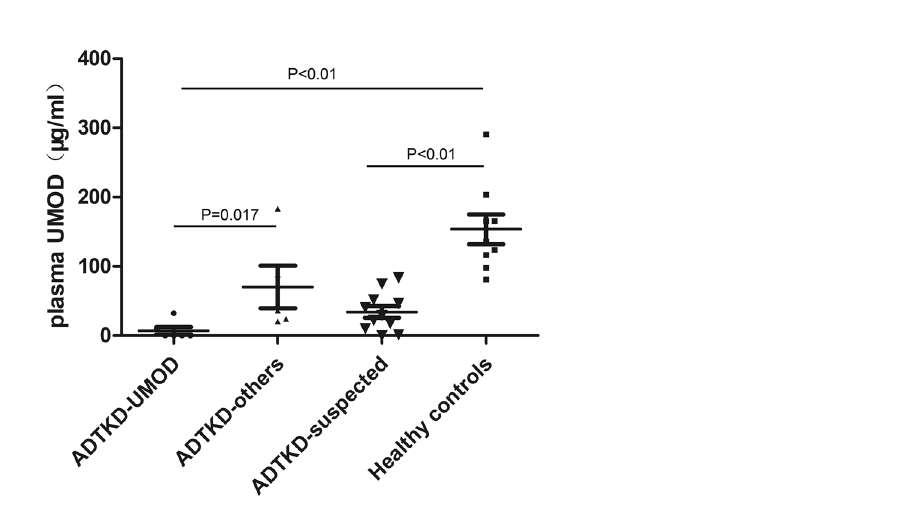
Figure 3. Uromodulin concentration of the individuals with suspected ADTKD in plasma. ADTKD-UMOD: ADTKD individuals with UMOD variants, n = 6; ADTKD-others: ADTKD individuals without UMOD variants, n = 5; ADTKD-suspected: individuals with suspected ADTKD, n = 11; healthy controls: n = 9. Data were expressed as mean ± standard deviation. In the cohort, ADTKD patients with a UMOD mutation expressed a lower plasma uromodulin concentration (7.05 ± 13.08 ng/ml) compared to patients without a UMOD mutation (70.3 ± 68.6 ng/ml). Both ADTKD-UMOD and the ADTKD-suspected (34.3 ± 28.0 ng/ml) group had a lower plasma concentration compared to healthy controls (153.5 ± 63.7